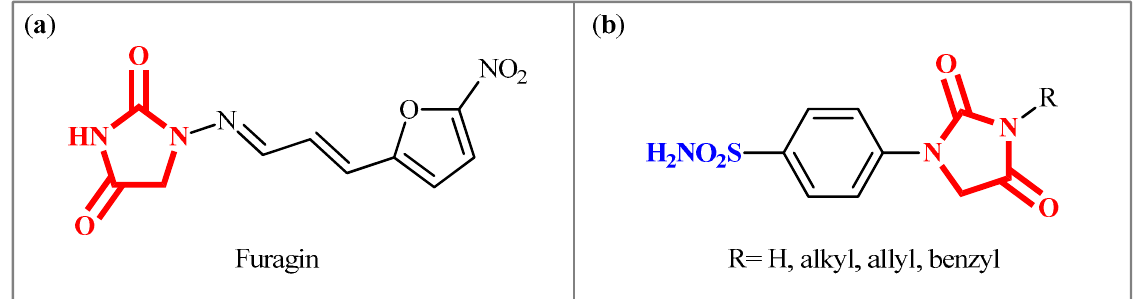
Figure 1. ( a ) Structure of Furagin; ( b ) General structure of 1-(4-benzenesulfonamide)-3-alkyl/benzyl-hydantoins discussed in the paper.